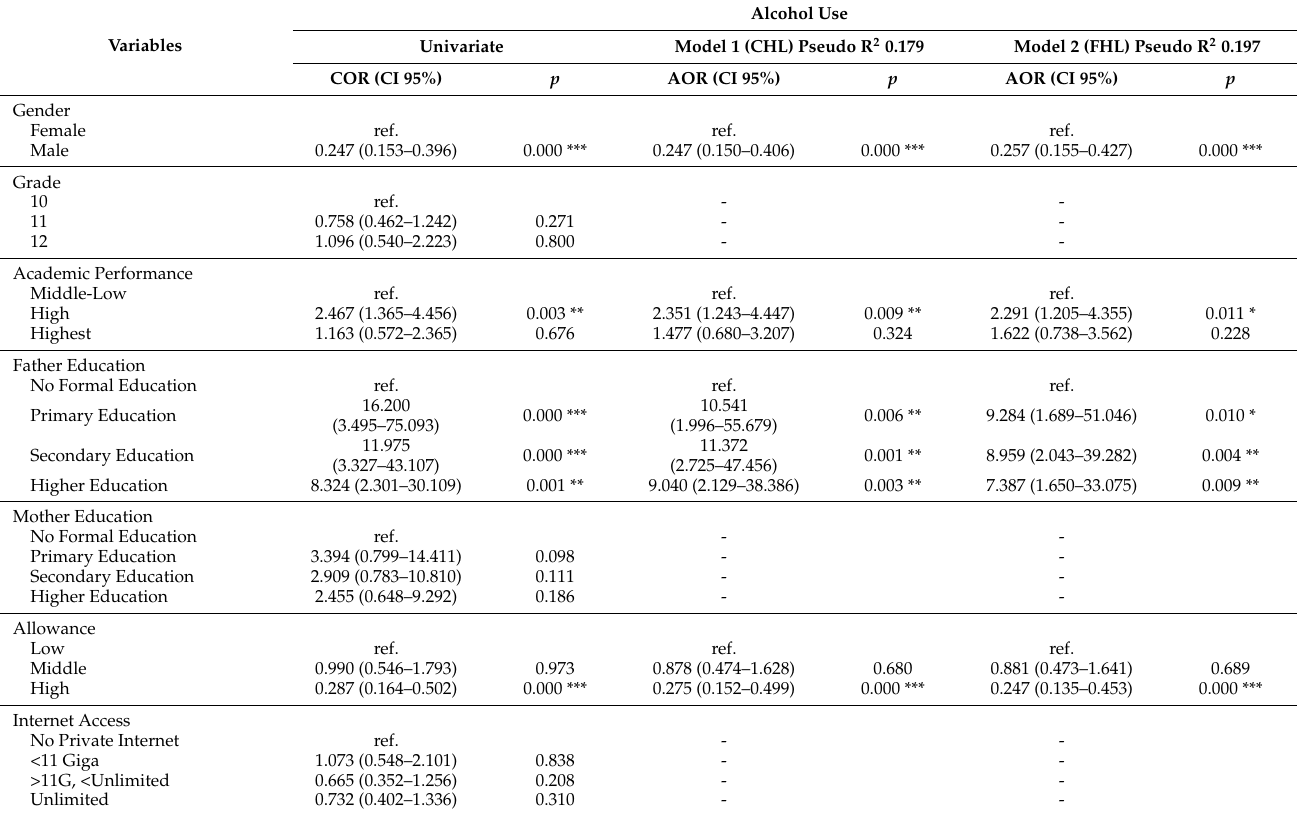
Table 7. Univariate and multivariate logistic regression of alcohol use with socioeconomic factors in the CHL and FHL models.